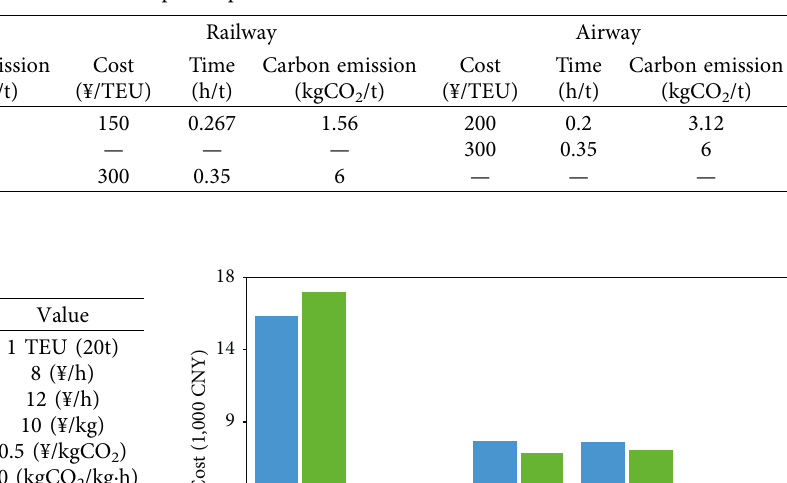
Table 5: Transshipment parameters.